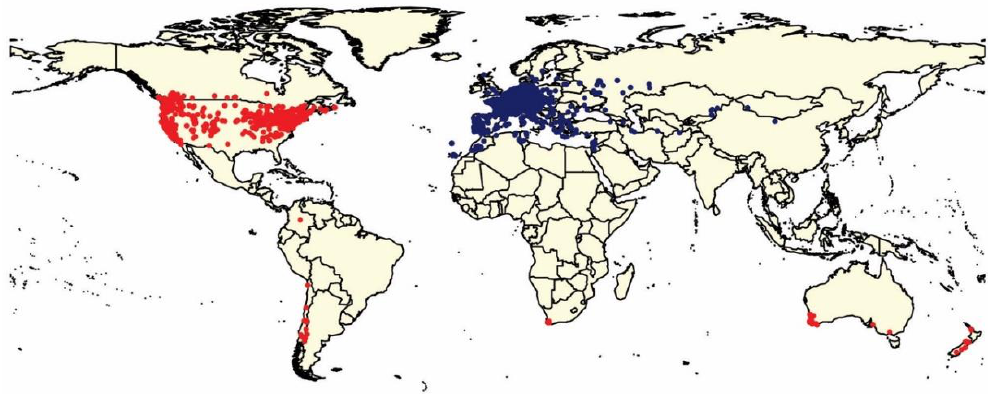
Figure 1. Global distribution of P. dominula constructed from data retrieved from Global Biodiversity Information Facility database (GBIF) [18]. Red points indicate occurrences in an invaded range. Blue points indicate occurrences in the assumed native range [5,6]. In total 9246 occurrences were used in this study. Of the total, 3028 occurrences were from invaded ranges and 6218 were from the assumed native range.